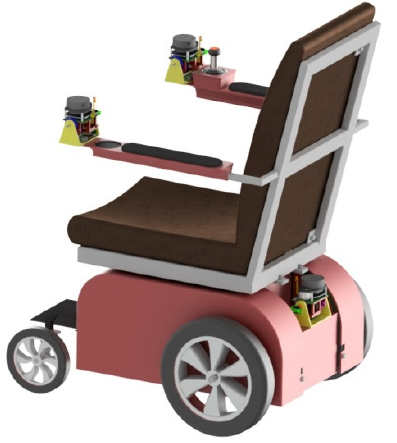
Figure 6. Map construction stages: ( a ) the first scan to create a map, ( b ) the second scan added to the map, ( c ) the map created after submitting several scans, and ( d ) visualization of the mapped room.